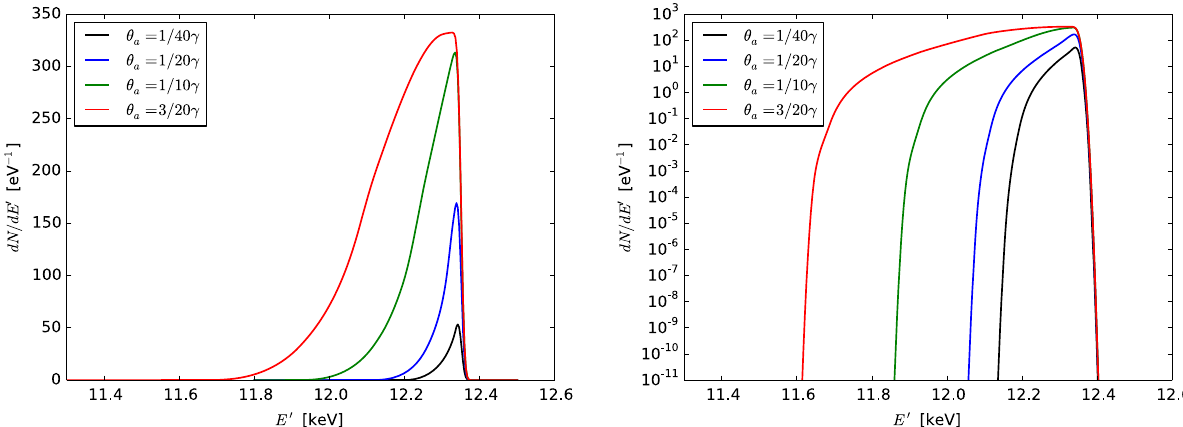
FIG. 12. Number spectra for the Old Dominion University Compton source with 10 pC electron bunch charge. Left: For apertures 1 = 40 γ , 1 = 20 γ , and 3 = 20 γ , 4,000 particles were used in generating each curve. For aperture 1 = 10 γ , 48 756 particles were used in generating the plot. Right: The same as the panel on the left, except on the log